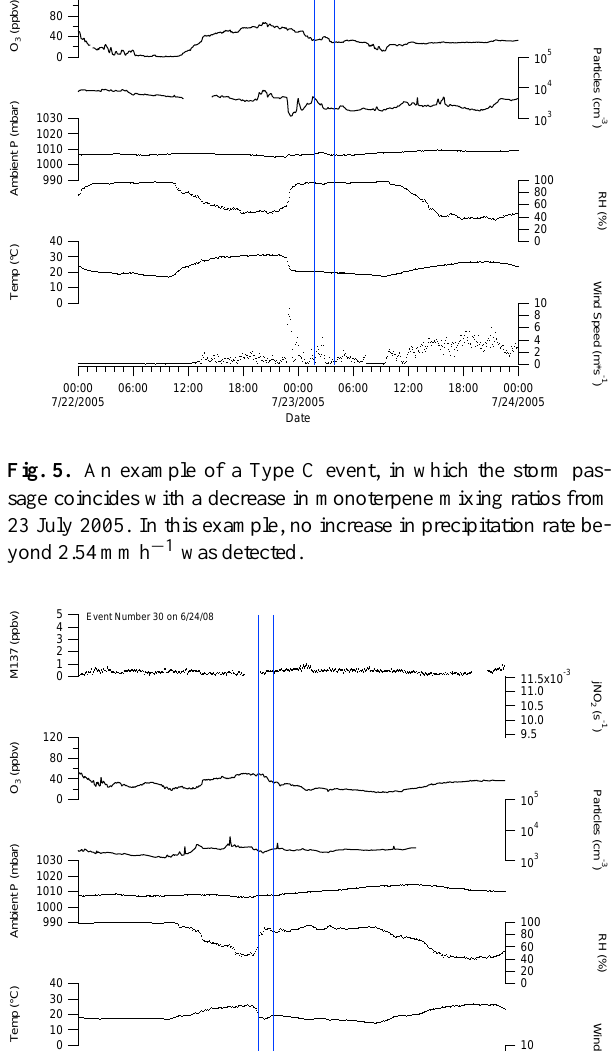
and Type C events decreased by 0.33 ± 0.13 ppbv ( − 23 %). Type D events showed average increase of 0.03 ± 0.01